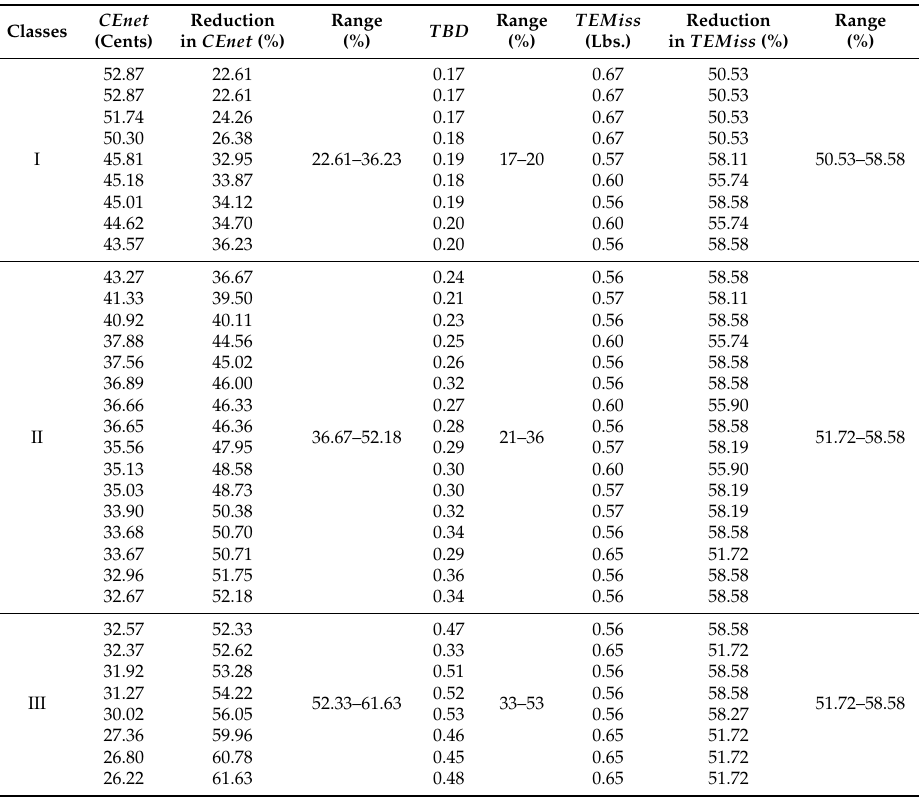
Table 14. Critical trade-off analysis for eco-efficient DRSREODLDG-BASED HEMS operation.